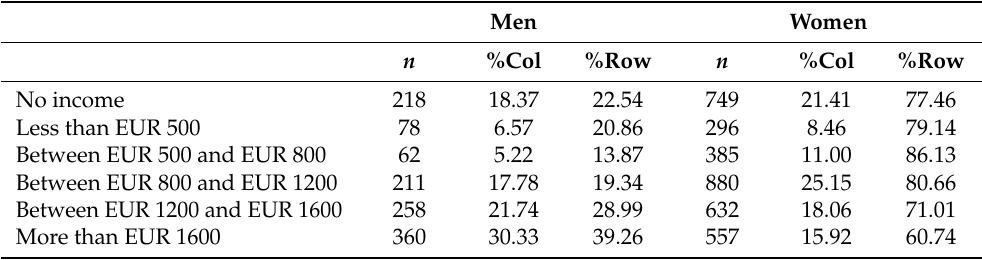
Table 2. Monthly salary and gender.